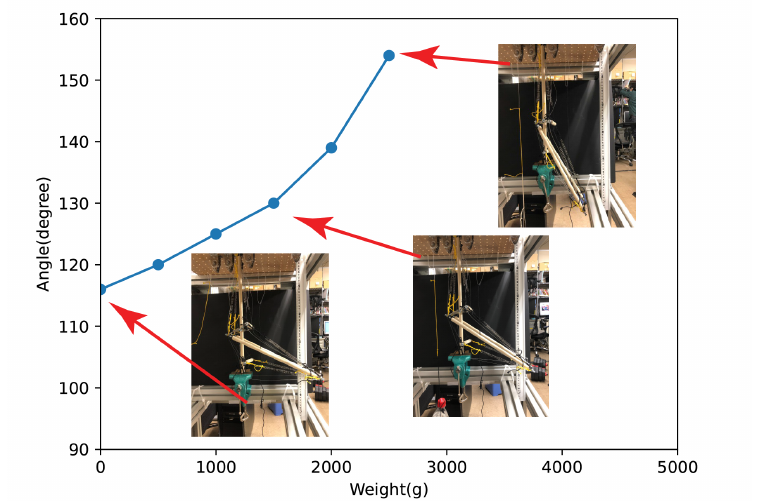
Figure 19. Graph of the angle between the upper arm and the lower arm when it is pulled downward by weights. Angles are measured based on images taken from a fixed camera. The embedded images show the states corresponding to the weights. For weights over 3000 g, measurements were stopped because the compression materials came into contact with each other, and the shape of the arm began to